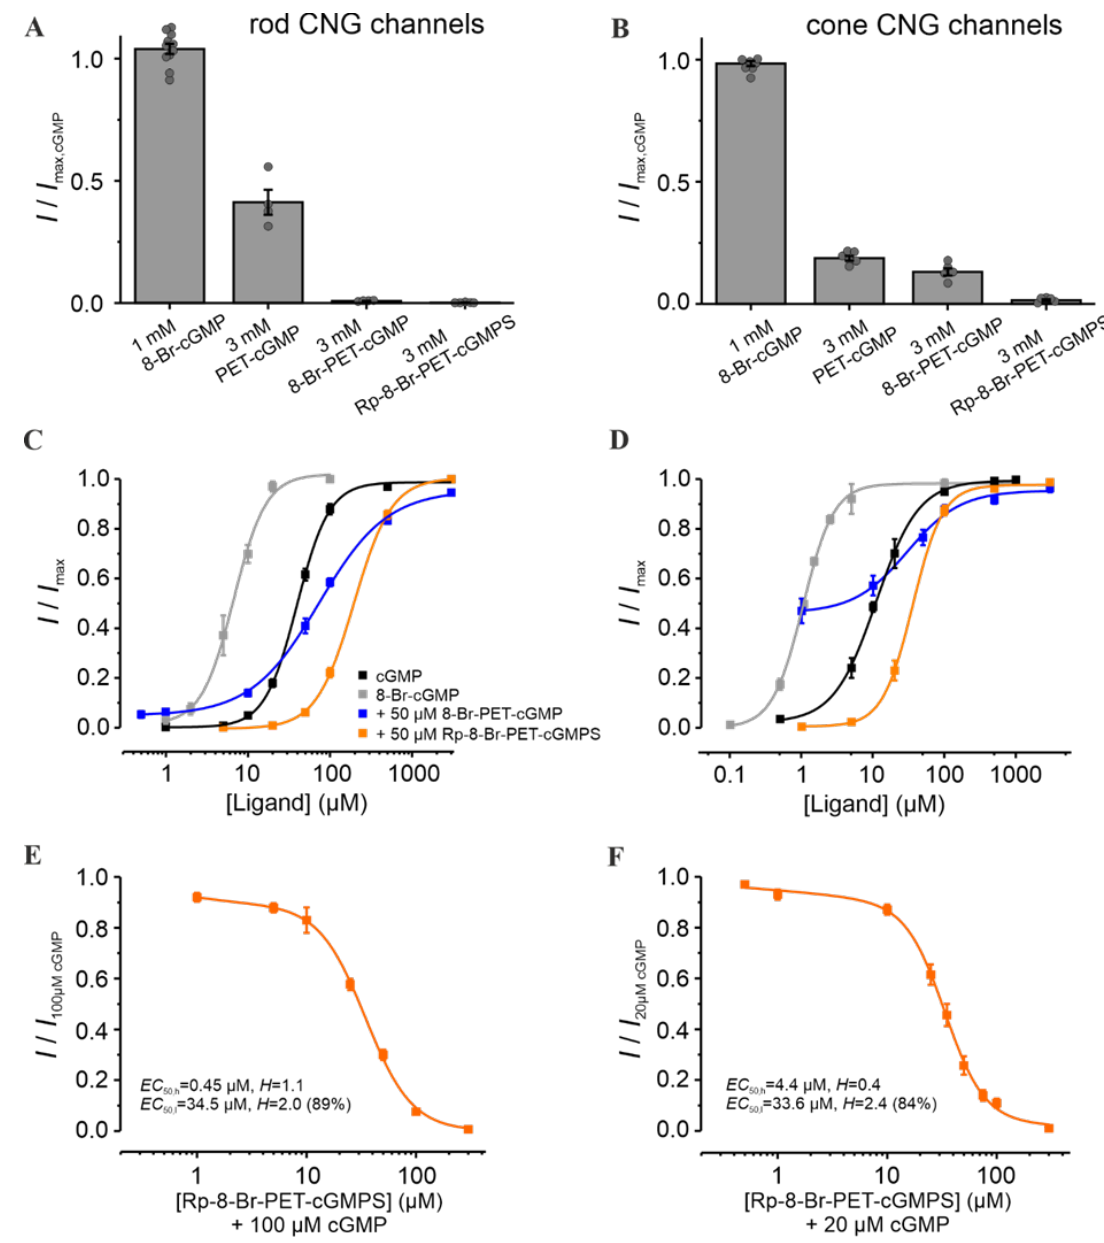
Figure 2. Effect of Rp-8-Br-PET-cGMPS and related cGMP analogues on retinal CNG channels. ( A , B ) Efficacy of 8-Br-cGMP, PET-cGMP, 8-Br-PET-cGMP and Rp-8-Br-PET-cGMPS when activating rod and cone CNG channels. The currents measured at +100 mV, in the presence of either 1 mM 8-Br- cGMP or 3 mM of the other cGMP analogues, were related to the maximal current induced by sat- urating cGMP (3 mM for rod and 1 mM for cone CNG channels; n = 4 – 11). The gray symbols repre- sent individual measurements. ( C , D ) Concentration – activation relationships for rod and cone CNG channels in the presence of cGMP (black), 8-Br-cGMP (gray), cGMP + 8-Br-PET-cGMP (50 µM, blue) and cGMP + Rp-8-Br-PET-cGMPS (50 µM, orange). The data points representing means of several experiments were fitted with Equation (1). ( E , F ) Rp-8-Br-PET-cGMPS-inhibitory effect on CNG channels in the presence of 100 µM and 20 µM cGMP for rod and cone CNG channels, respectively. The experimental data points representing means of several measurements were fitted with Equa- tion (2) ( n = 8 – 16 for rod; n = 5 – 12 for cone; for EC 50 , H, and n, see Table S1).